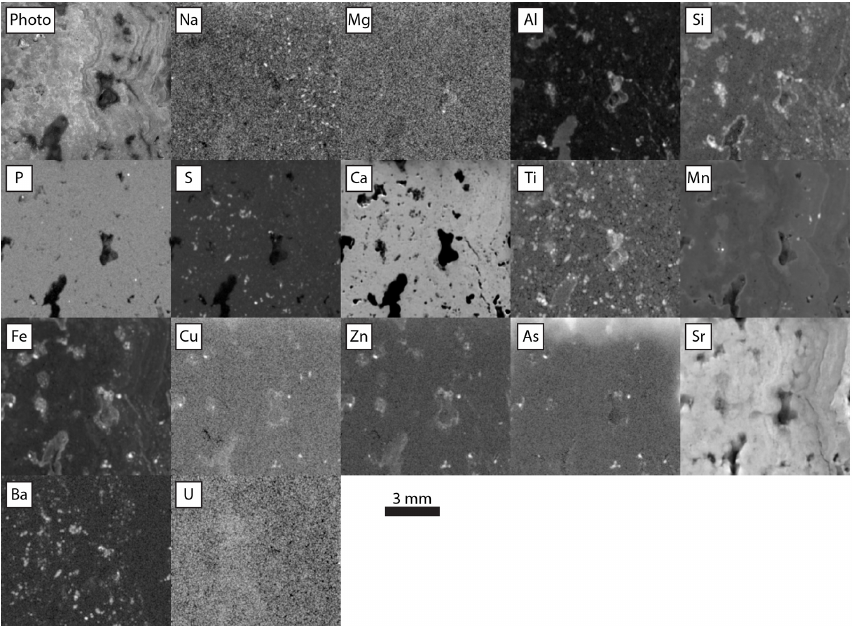
Figure 11. Relative intensities of emission regions for each element detected in Barstow tufa, imaged at 25µm pixels with a 400ms per pixel dwell time and 1.5SD Gaussian blur. Each panel is adjusted in terms of gamma and contrast to emphasize gradients between texture. Na through Fe data collected with no incident radiation filter. Cu through U data collected with incident radiation filtered with 100µm Al, 50µm Ti, and 20µm Cu